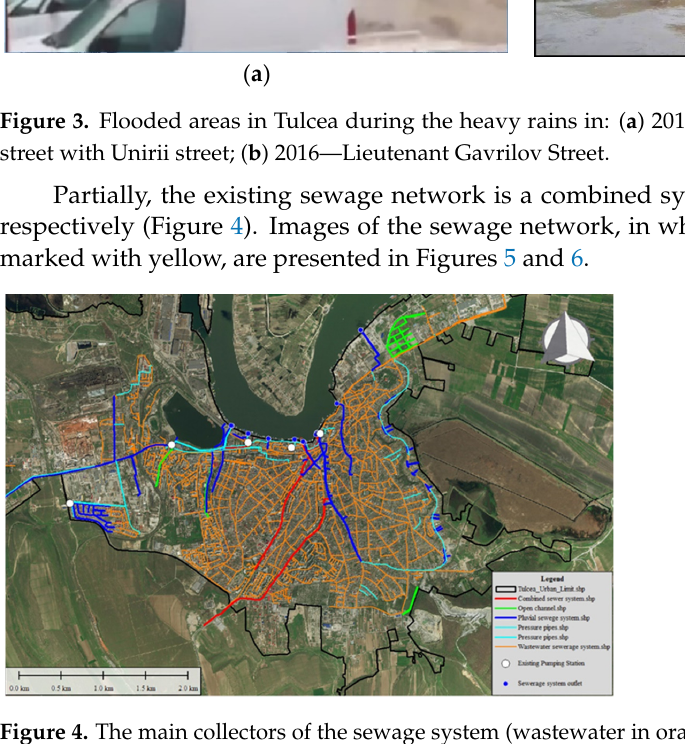
Figure 5. Most sensitive areas (yellow) and the pluvial drainage system. Figure 6. Main sensitive areas in case of pluvial floods and the corresponding main streets.